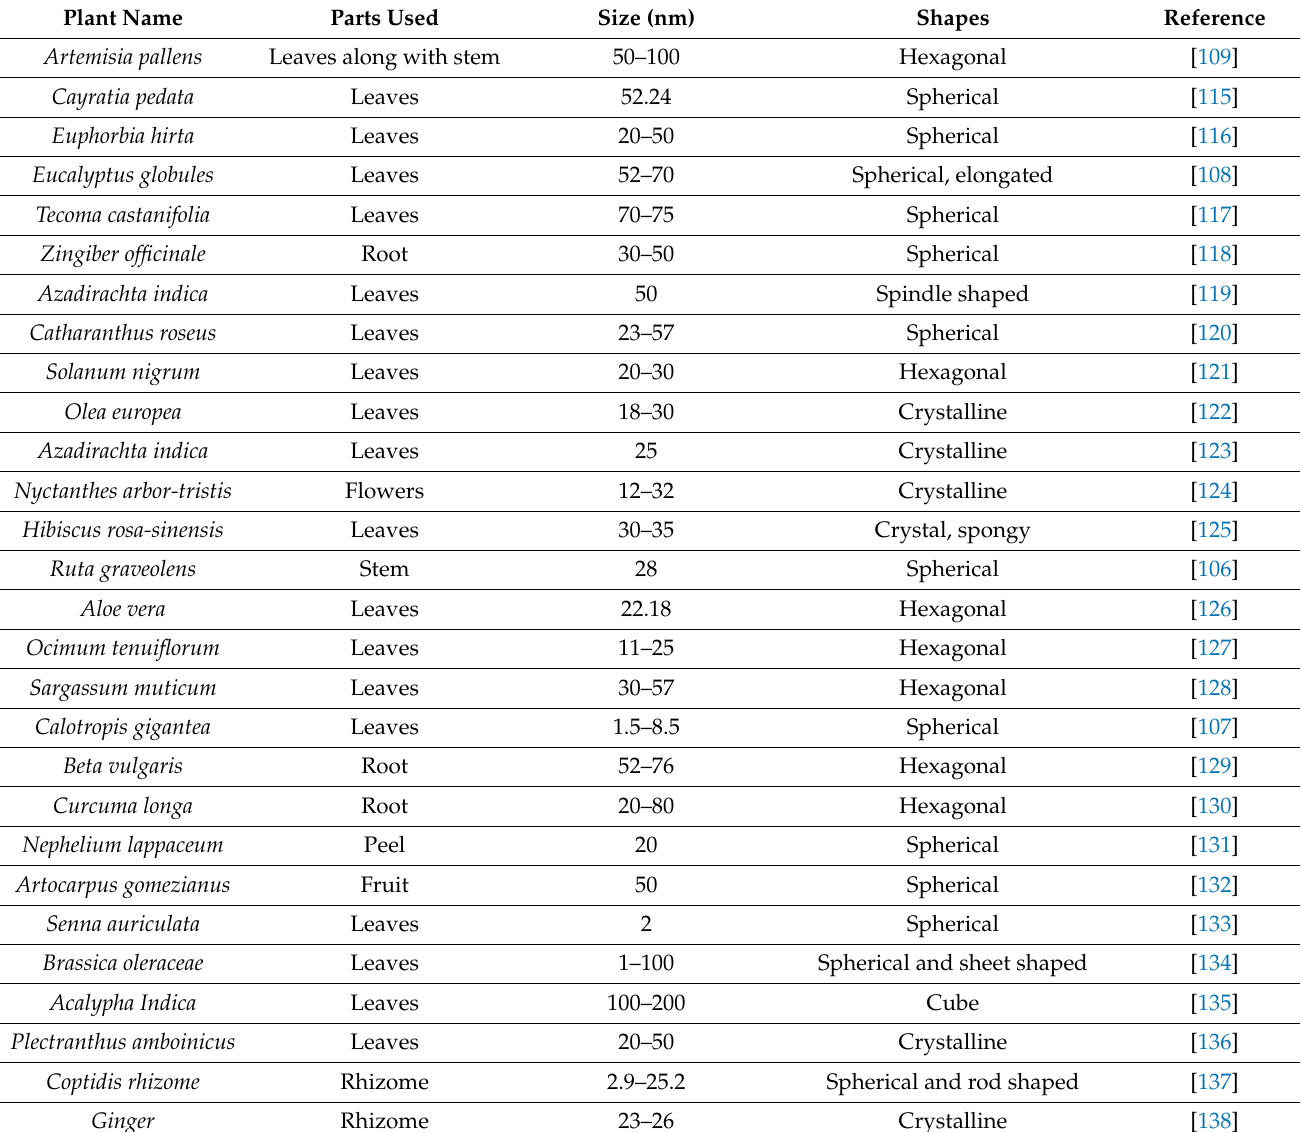
Table 3. Plant-assisted synthesis of zinc